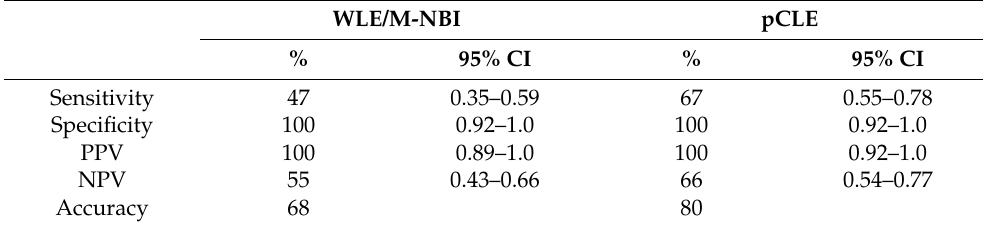
Table 2. WLE/M-NBI versus pCLE for diagnosing residual gastric cancer.